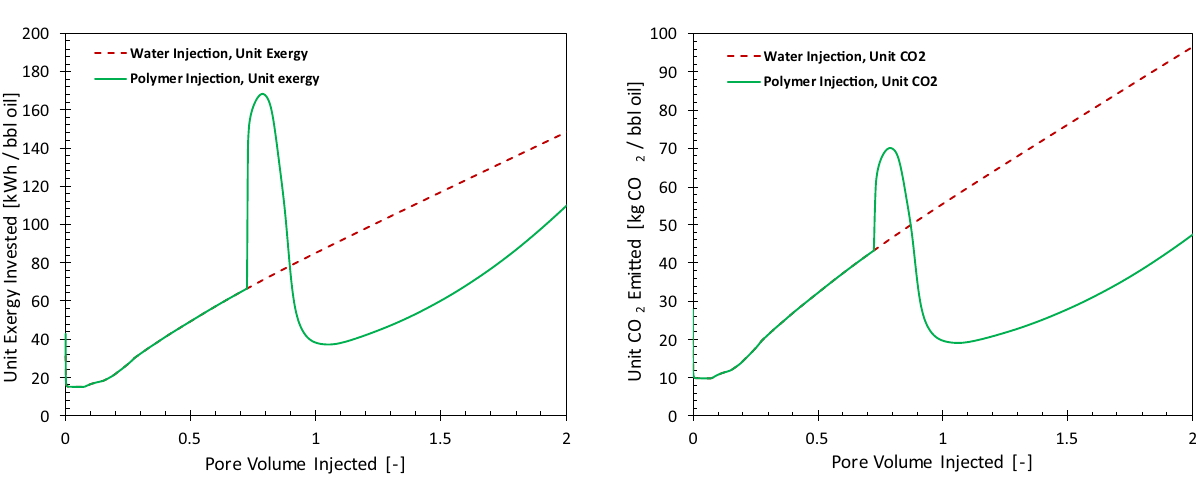
Figure 5. Histories of the unit energy consumed (left) and unit CO 2 emitted (right) for water injection (dashed line) and polymer injection (solid line) After 2 PV of total injection, about 9% of the oil exergy is invested in producing it. With the injection of polymer, the exergy recovery factor suddenly decreases, because at this stage the exergy invested for manufacturing and injecting polymer is larger than the exergy gain from oil. However, once the oil bank created by the injected polymer solution arrives at the producers, the exergy gain from oil surpasses the exergy investment and the exergy recovery factor increases. The maximum exergy recovery factor in Fig. 4 corresponds to the minimum in the water cut for the PI case in Fig. 2, which reiterates the negative impact of circulation of large volumes of water on the energy efficiency of the oil production systems. The area enclosed between the dashed line (decline curve for waterflooding) and the polymer injection is the incremental exergy gain (the area above the dashed line) or loss (area below the dashed line). The net exergy recovery is the difference between the upper area and the lower area. It is possible to get a negative net exergy recovery for polymer flooding compared to water flood- ing, especially when the injection of polymer does not efficiently reduce the water cut. Figure 5 compares the unit exergy invested (left) and the unit emitted CO 2 (right) of WI (dashed red curve) and PI (solid green curve) cases. For the WI case, the unit exergy investment and the unit CO 2 emission keeps increasing in accordance with the increase in volumes of injected and produced water. With the start of the polymer injection, the exergy investment also increases, which results in a larger unit CO 2 emission due to exergy investments in manufacturing and shipment of the injected polymer. However, once the injection of polymer reduces the water cut, both exergy investment and CO 2 emissions are reduced. For example, at 1 PV of total injec- tion, the unit CO 2 emission decreases to 20 kgCO 2 /bbl from the base case of 55 kgCO 2 /bbl. Figure 6 presents the fractions of the unit exergy invested and unit CO 2 emitted for the PI case. At the start of the polymer injection, the energy invested on artificial lift and injection pumps comprise 68% of the exergy consumed for producing the oil. Of the other parts of the invested energy water treatment is a large contributor. A large invested exergy is